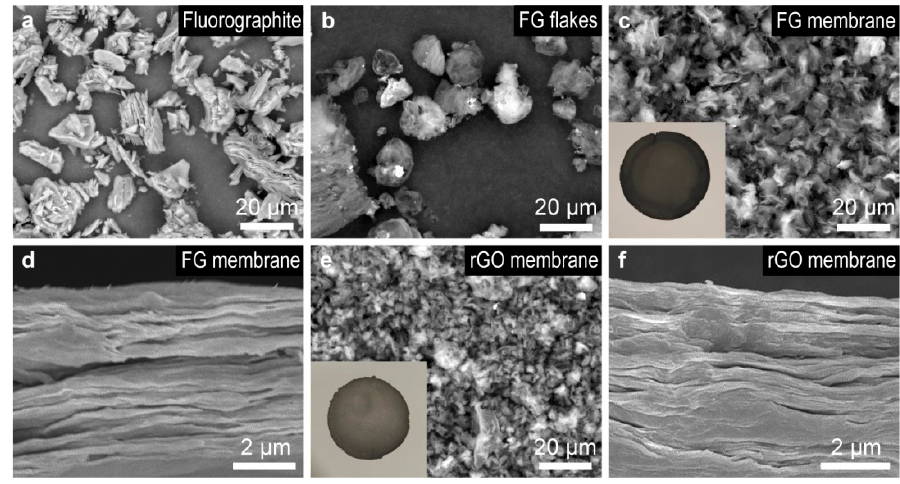
Scheme 1. Preparation of FG membranes and FG-PTFE membranes.